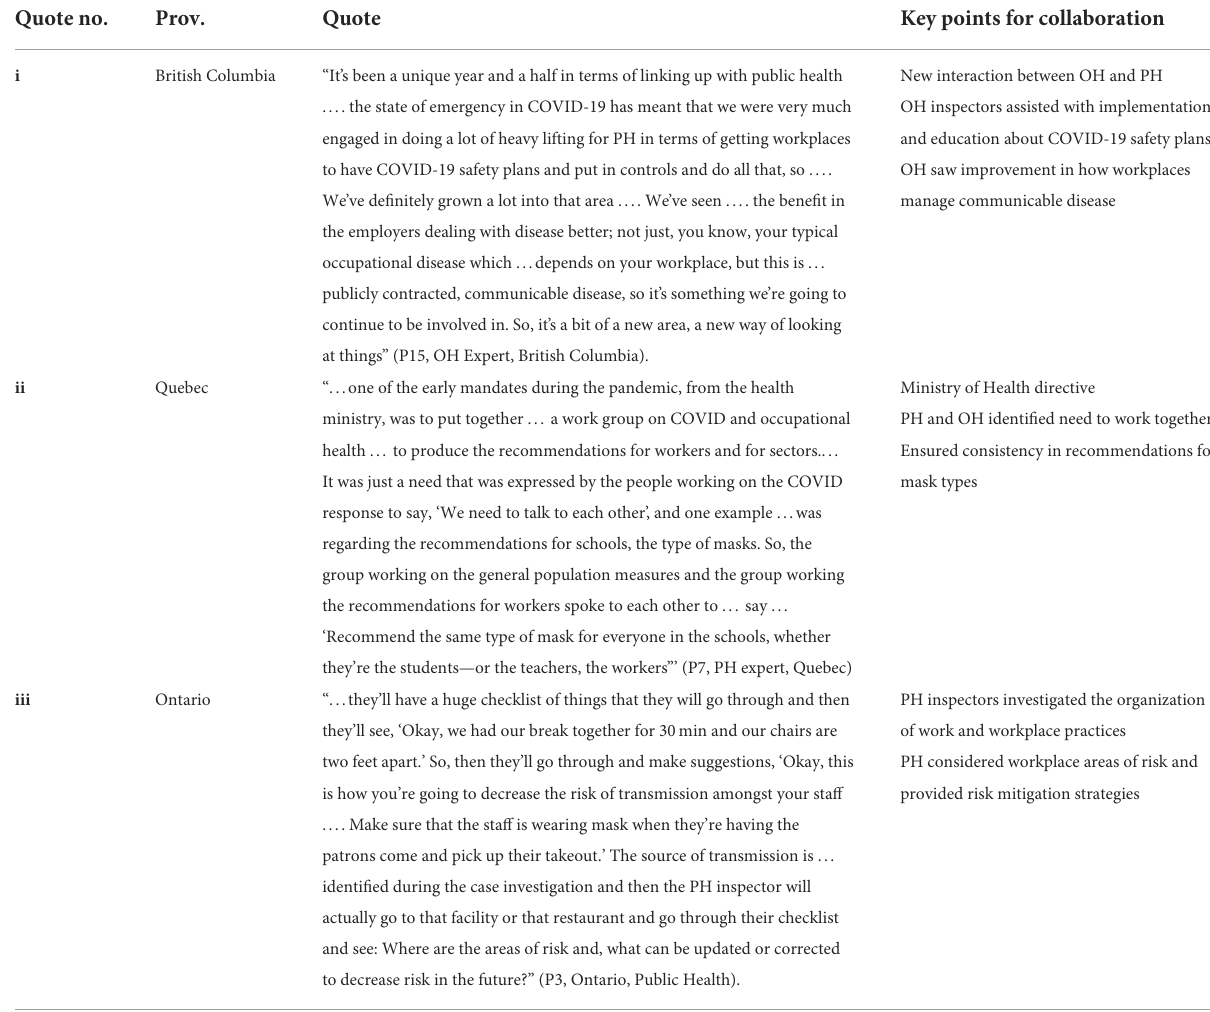
TABLE 3 Strengths key points identified from quotes about PH-OH pandemic response and KI province. Quote no. Prov.